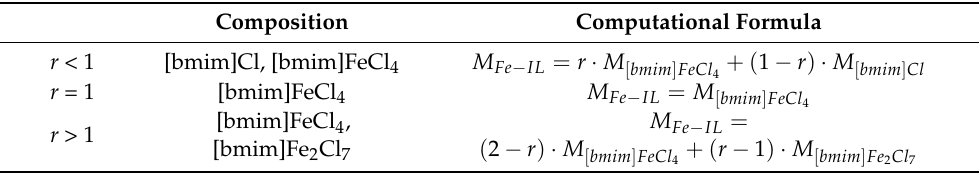
Table 1. Calculation method for the molar mass ( M ) of different composition ratios of r FeCl 3